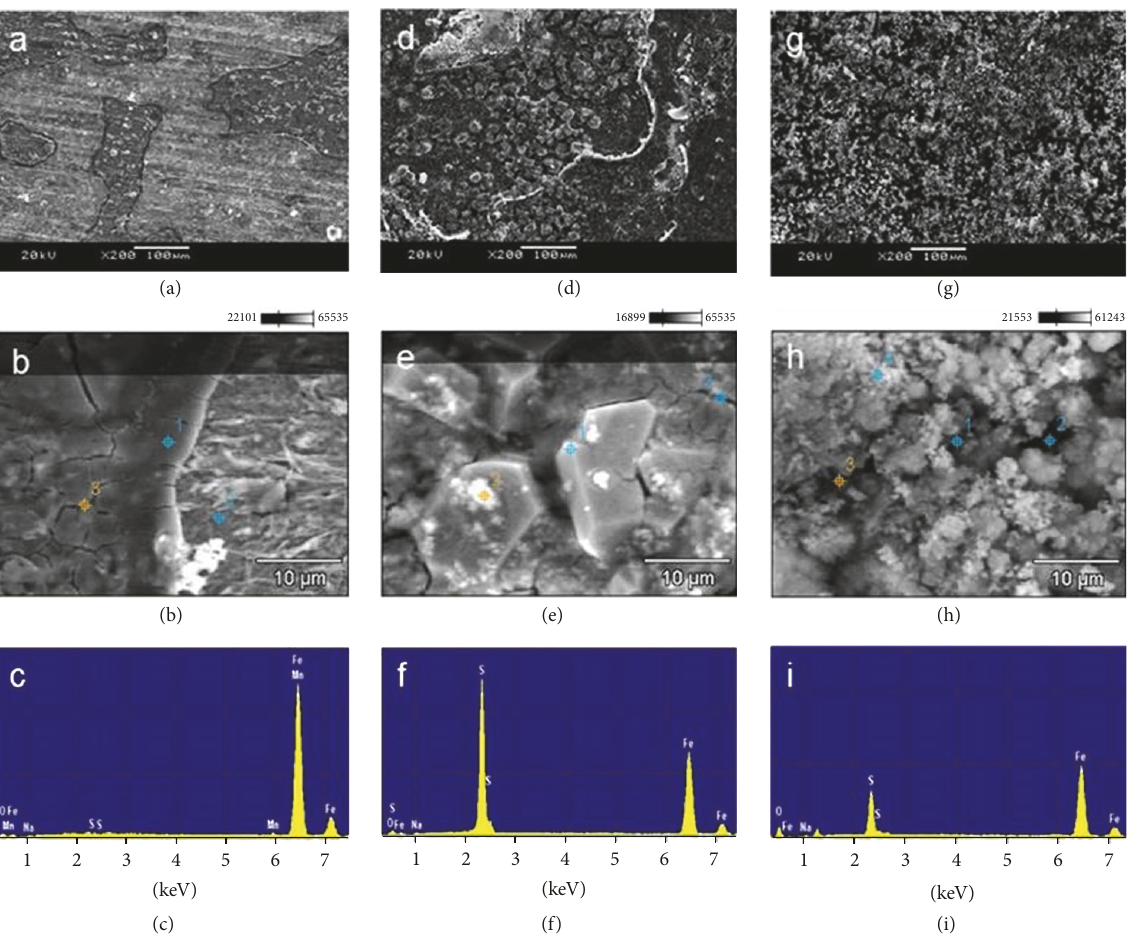
Figure 6: SEM and EDS analyses of corrosion products in the API 5L X52MS steel. This steel exposed to 177-A solution: (a) 200x, (b) 3000x, and (c) EDS. This one exposed to 177-B solution: (d) 200x, (e) 3000x, and (f) EDS. This one exposed to 284-B solution: (g) 200x, (h) 3000x, and (i) EDS.